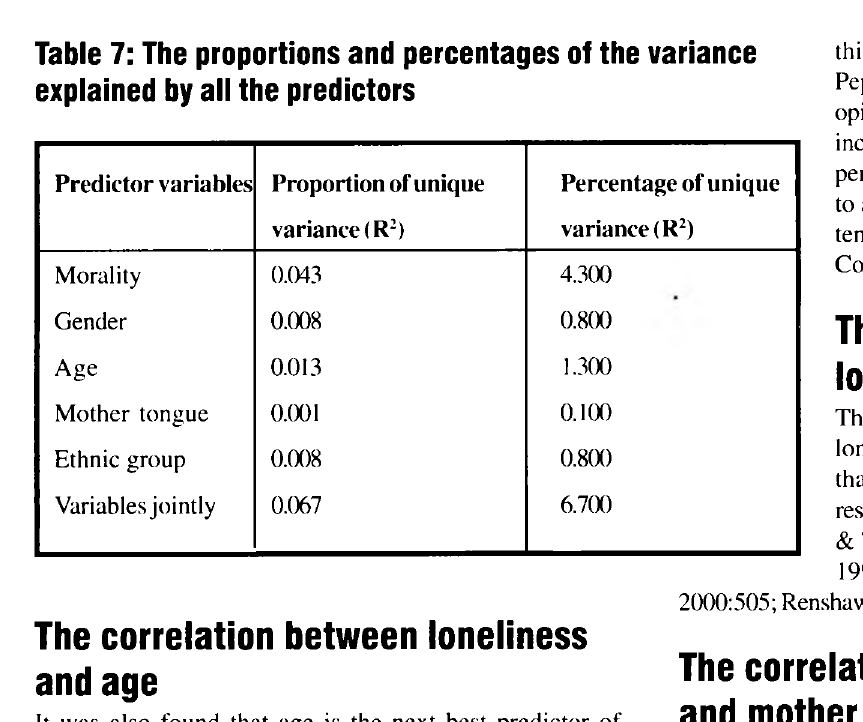
Table 7 : The proportions and percentages of the variance explained by all the predictors